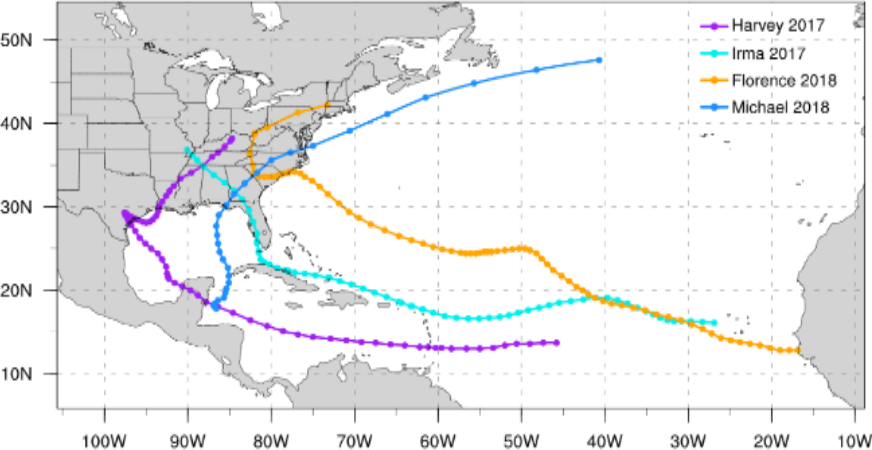
Figure 3. The National Hurricane Center (NHC) best tracks for the four Atlantic hurricanes used in this study.